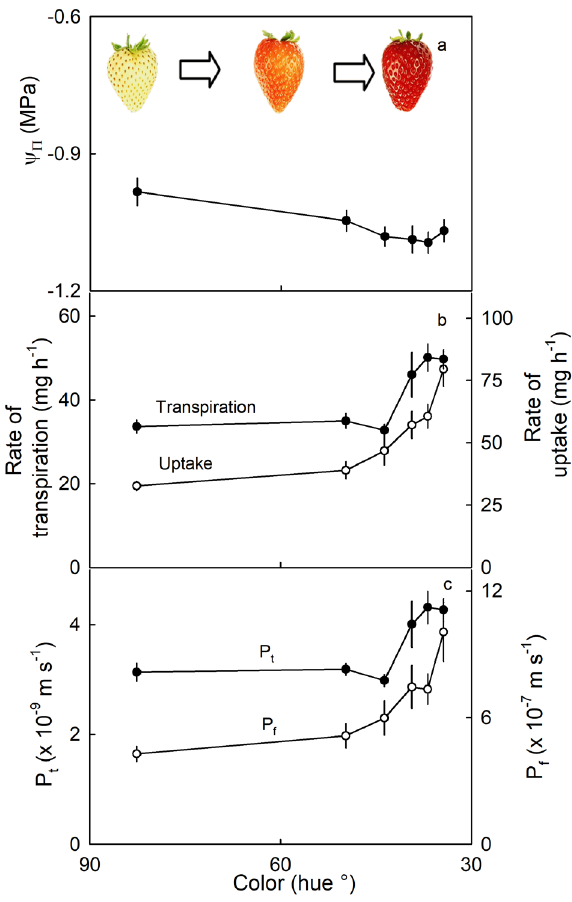
Figure 2. Changes during ripening of strawberry fruit indexed by ( a ) osmotic potential ( (cid:31) (cid:30) ), ( b ) the rates of transpiration and uptake, and ( c ) the permeances for transpiration (P t ) and water uptake (P f ) of ‘Florentina’ strawberry. The time of ripening was indexed by the change in color.